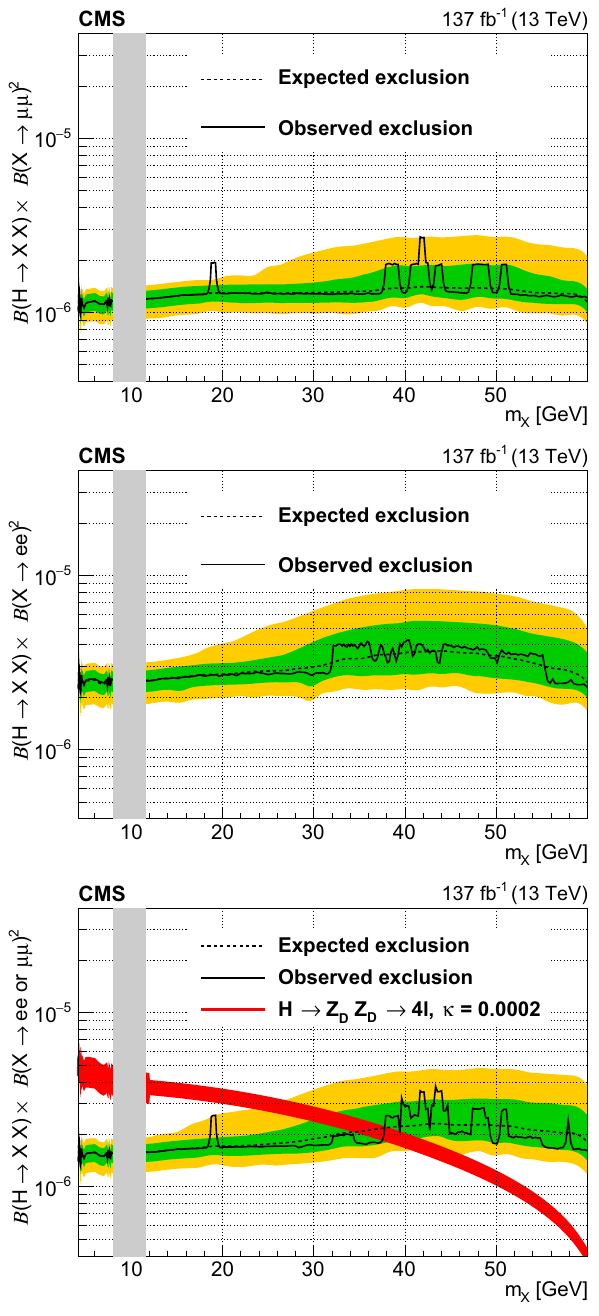
Fig. 5 Expected and observed 95% CL limits on B ( H → XX ) B ( X → μμ ) 2 assuming X decays to dimuons only, B ( H → XX ) B ( X → ee ) 2 assuming X decays to dielectrons only, and B ( H → XX ) B ( X → ee or μμ) 2 assuming a flavor symmetric decay of X to dimuons and dielectrons. The dashed black curve is the expected upper limit, with one and two standard-deviation bands shown in green and yellow, respectively. The solid black curve is the observed upper limit. The red curve represents the theoretical cross section for the signal process H → XX → 4 (cid:2) . The discontinuity at 12GeV in uncertainty is due to the switch from experimental to theoretical uncertainty estimates of → ee or μμ ) , as described in Ref. [7]. The symbol κ is the Higgs- B ( Z D mixing parameter. The grey band corresponds to the excluded region around the bb bound states of Υ